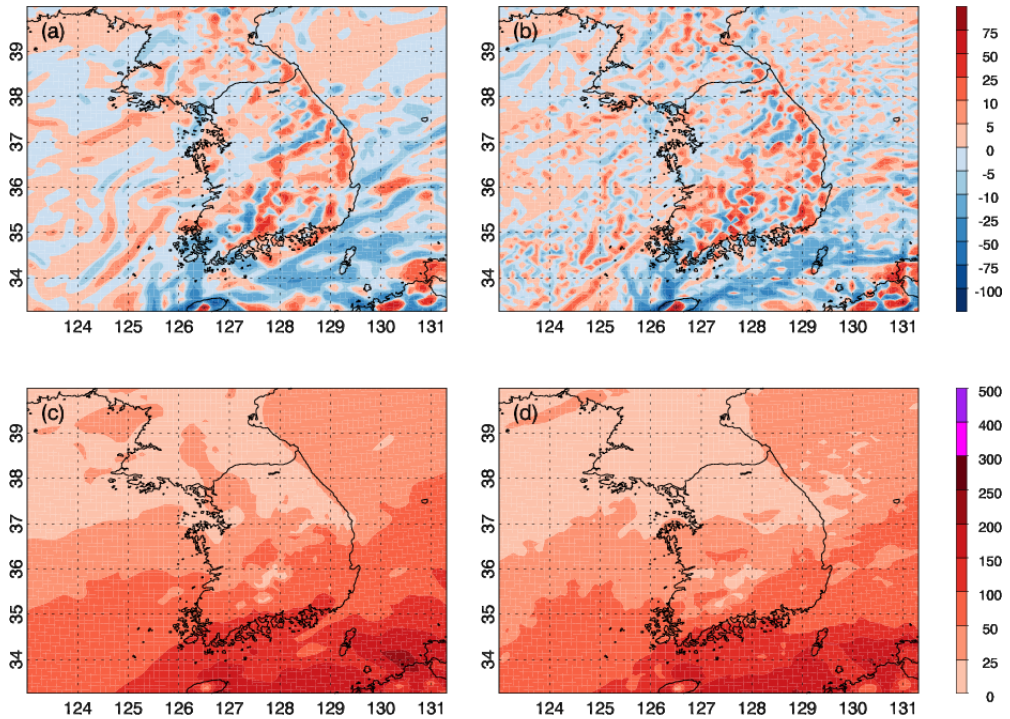
Figure 10. Moisture flux divergence ( × 10 − 4 gkg − 1 s − 1 ) for (a) CTRL_Mar and (b) DA_Mar, and magnitude of moisture transport (gkg − 1 ms − 1 ) for (c) CTRL_Mar and (d) DA_Mar for 925hPa and at 16:00UTC 7 March